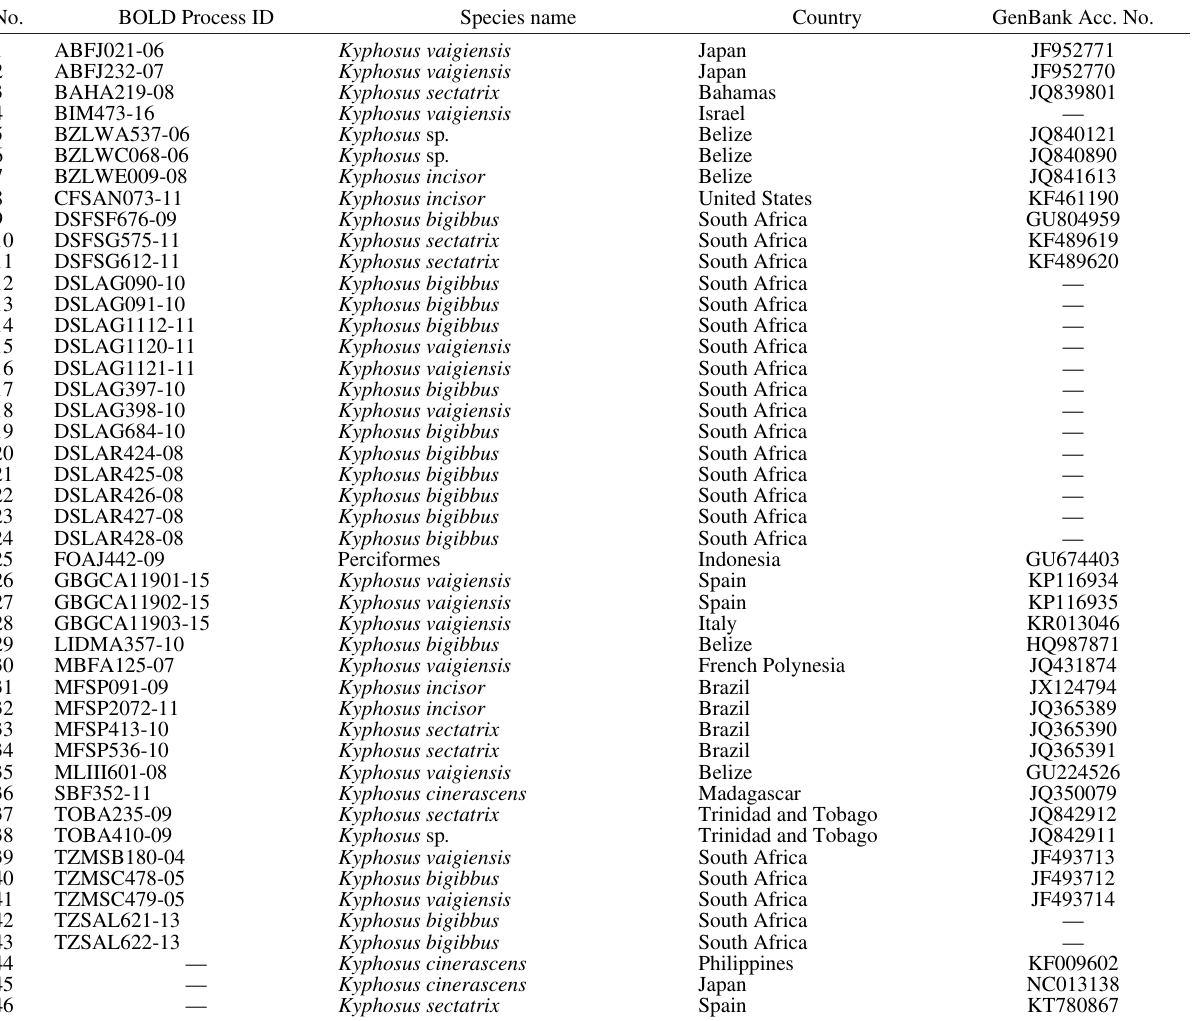
Table 1. – List of specimens employed in this